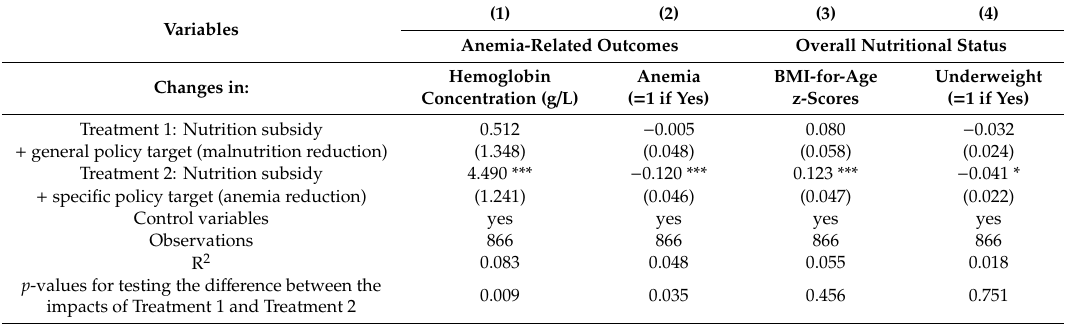
Table 3. Impacts of nutrition treatments on students’ nutritional outcomes and dietary